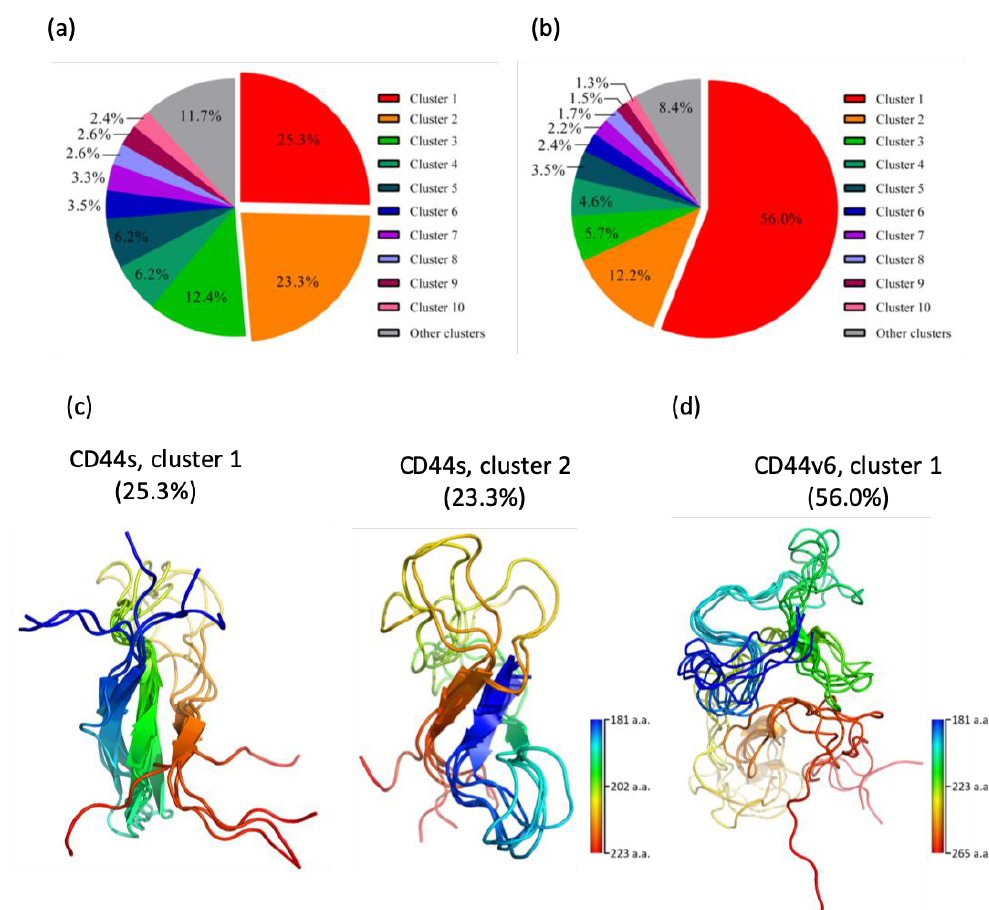
Figure 3. Clustering analysis of the CD44s and CD44v6 stem regions. ( a ) Population distribution of each cluster of the CD44s stem region. ( b ) Population distribution of each cluster of the CD44v6 stem region. ( c ) Structures of the most populated clusters of the CD44s stem region, cluster 1 and cluster 2. ( d ) Structures of the most populated cluster of the CD44v6 stem region, cluster 1. Ensemble structures are rainbow-colored from blue at the N -terminus to red at the C -terminus.